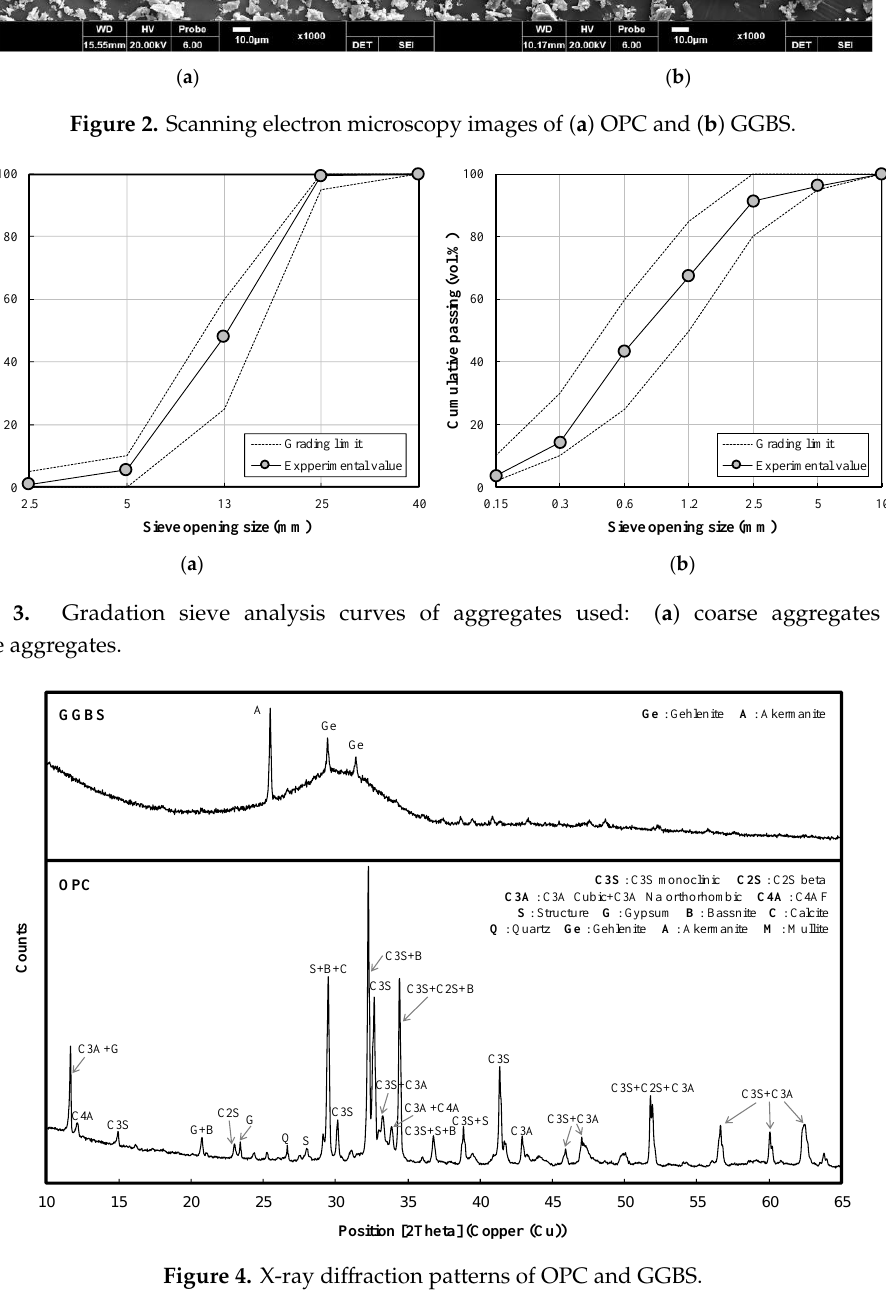
Figure 4. X-ray di ff raction patterns of OPC and Figure 4. X-ray diffraction patterns of OPC and GGBS.